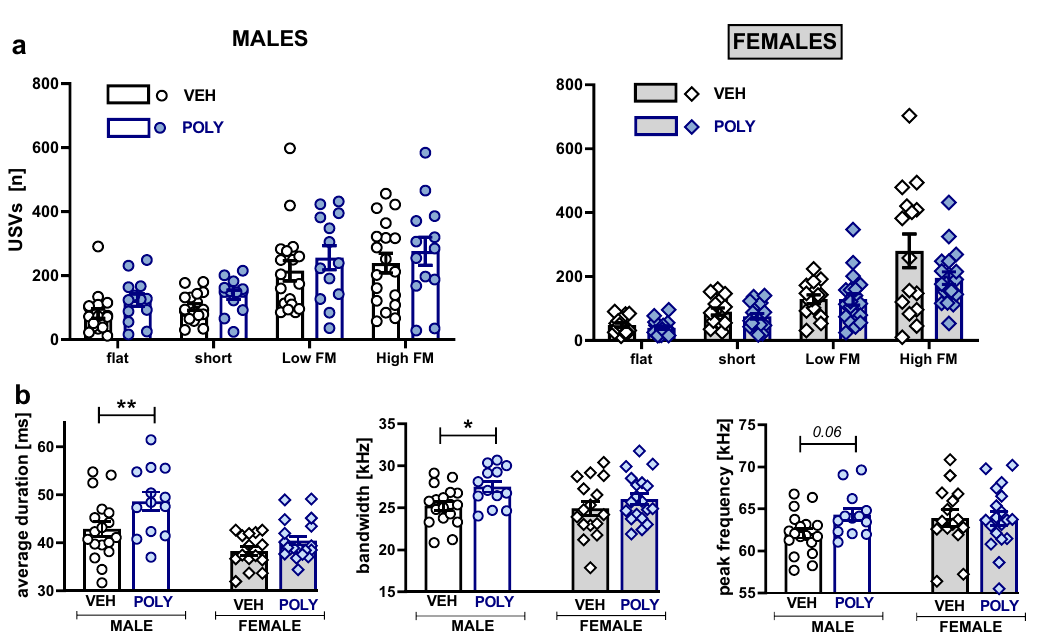
Figure 4. Vocalizations during the social interaction test: USV categories. Poly(I:C) exposure did not affect the number of USVs within categories ( a ) but changed the acoustic characteristics of high frequency modulated (HFM) sounds ( b ). Data are presented as a mean ± SEM of the number of a given call type ( a ) and average duration, bandwidth, and peak frequency ( b ) of the HFM calls. Symbols: *p < 0.05, **p < 0.01, a significant difference between vehicle- and poly(I:C)-exposed males (planned